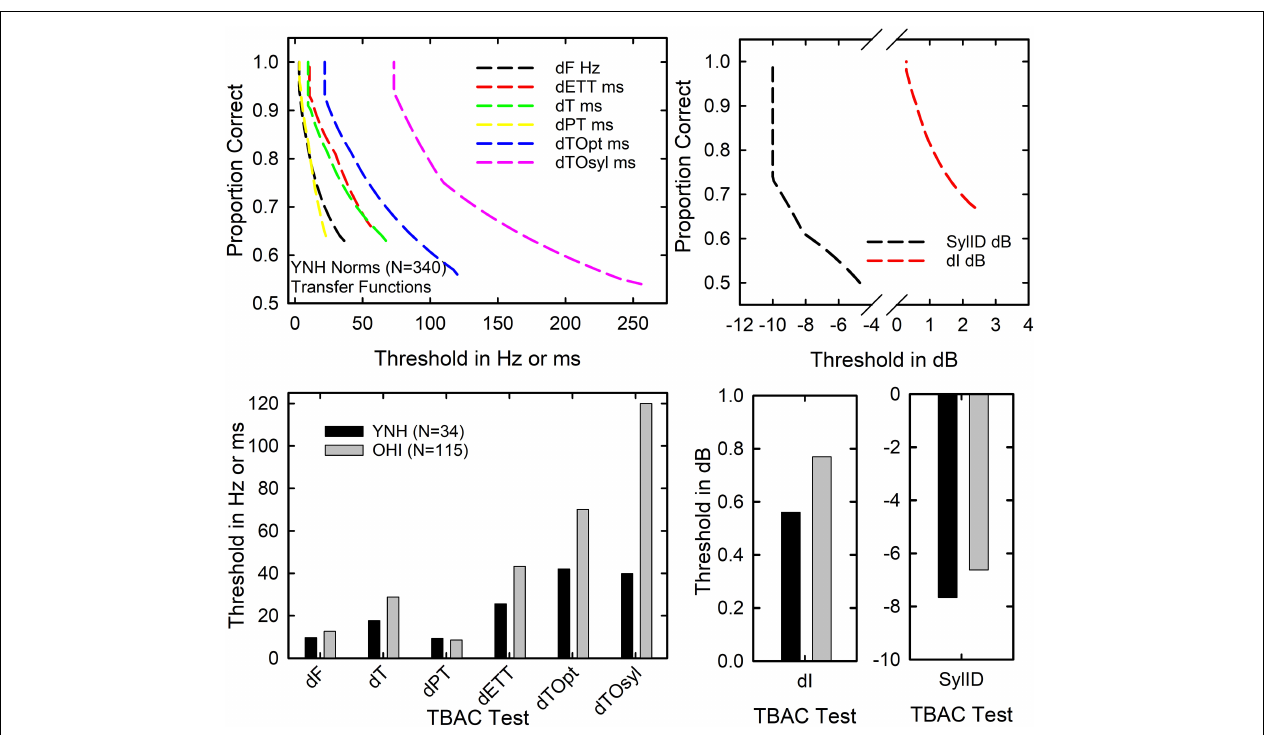
FIGURE 3 | The top two panels show the transfer functions from the group data ( N = 340) of Kidd et al. (2007) relating the proportion correct on a given TBAC test to the underlying stimulus dimension manipulated on that test. The lower two panels show the physical stimulus change needed at the median percent-correct performance on each TBAC test for the YNH (black bars) and OHI (gray bars)